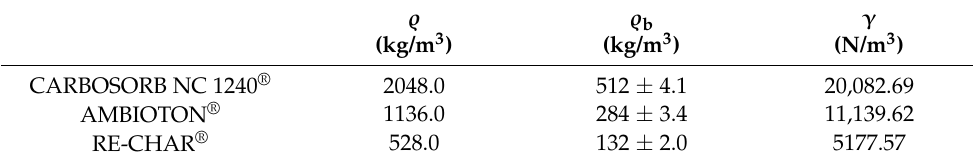
Table 1. Density ( (cid:36) ), bulk density ( (cid:36) b ), and specific weight ( γ ) of the carbonaceous